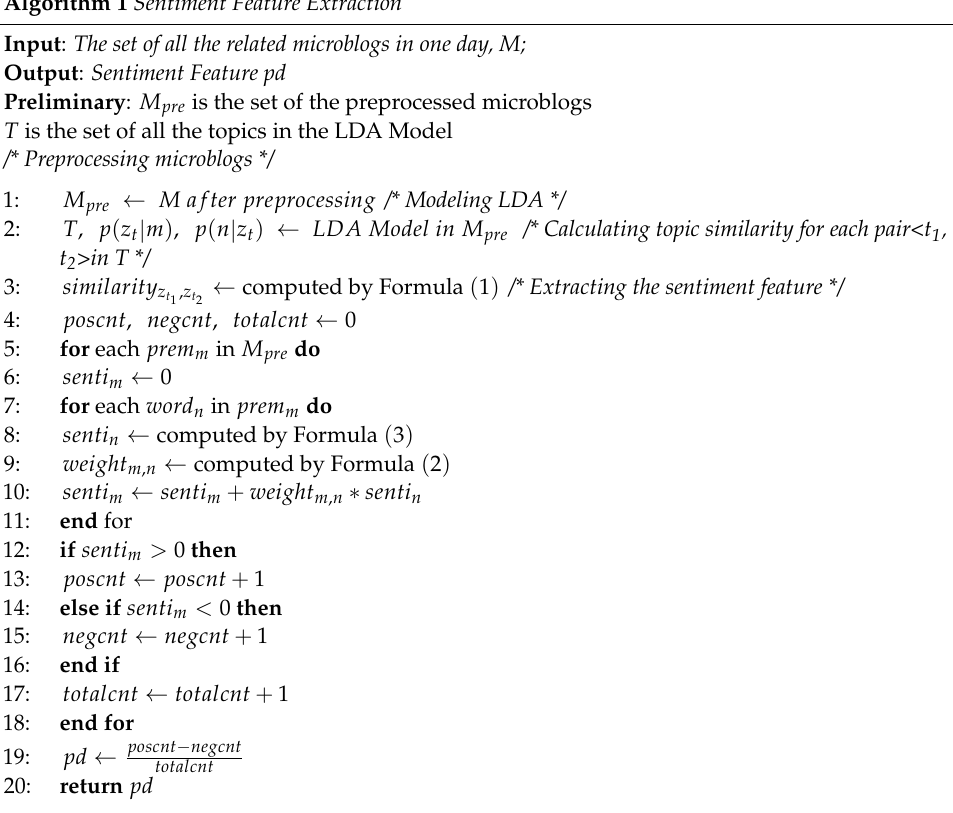
Algorithm 1 Sentiment Feature